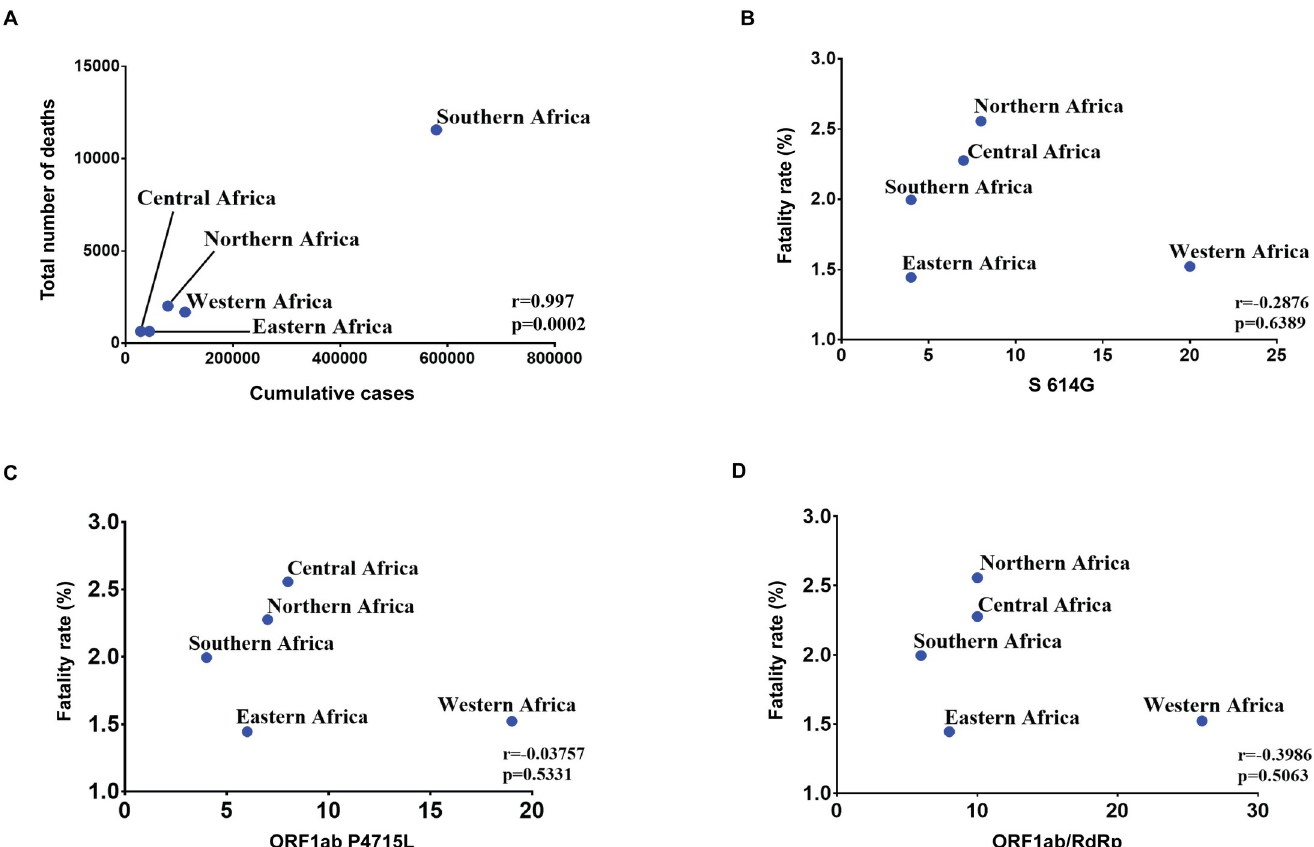
Fig 2. Correlation analysis of COVID-19 cases and mutant variants with fatality rate. Correlation analysis of cumulative cases with number of deaths (a); variant frequencies of SARS-CoV-2’ S 614G with fatality rates of COVID-19 among the five regions of Africa (b); ORF1ab P4715L with fatality rates of COVID-19 among the five regions of Africa (c); ORF1ab/RdRp with fatality rates of COVID-19 among the five regions of Africa (d). Pearson’s correlation coefficients (r) and p values were